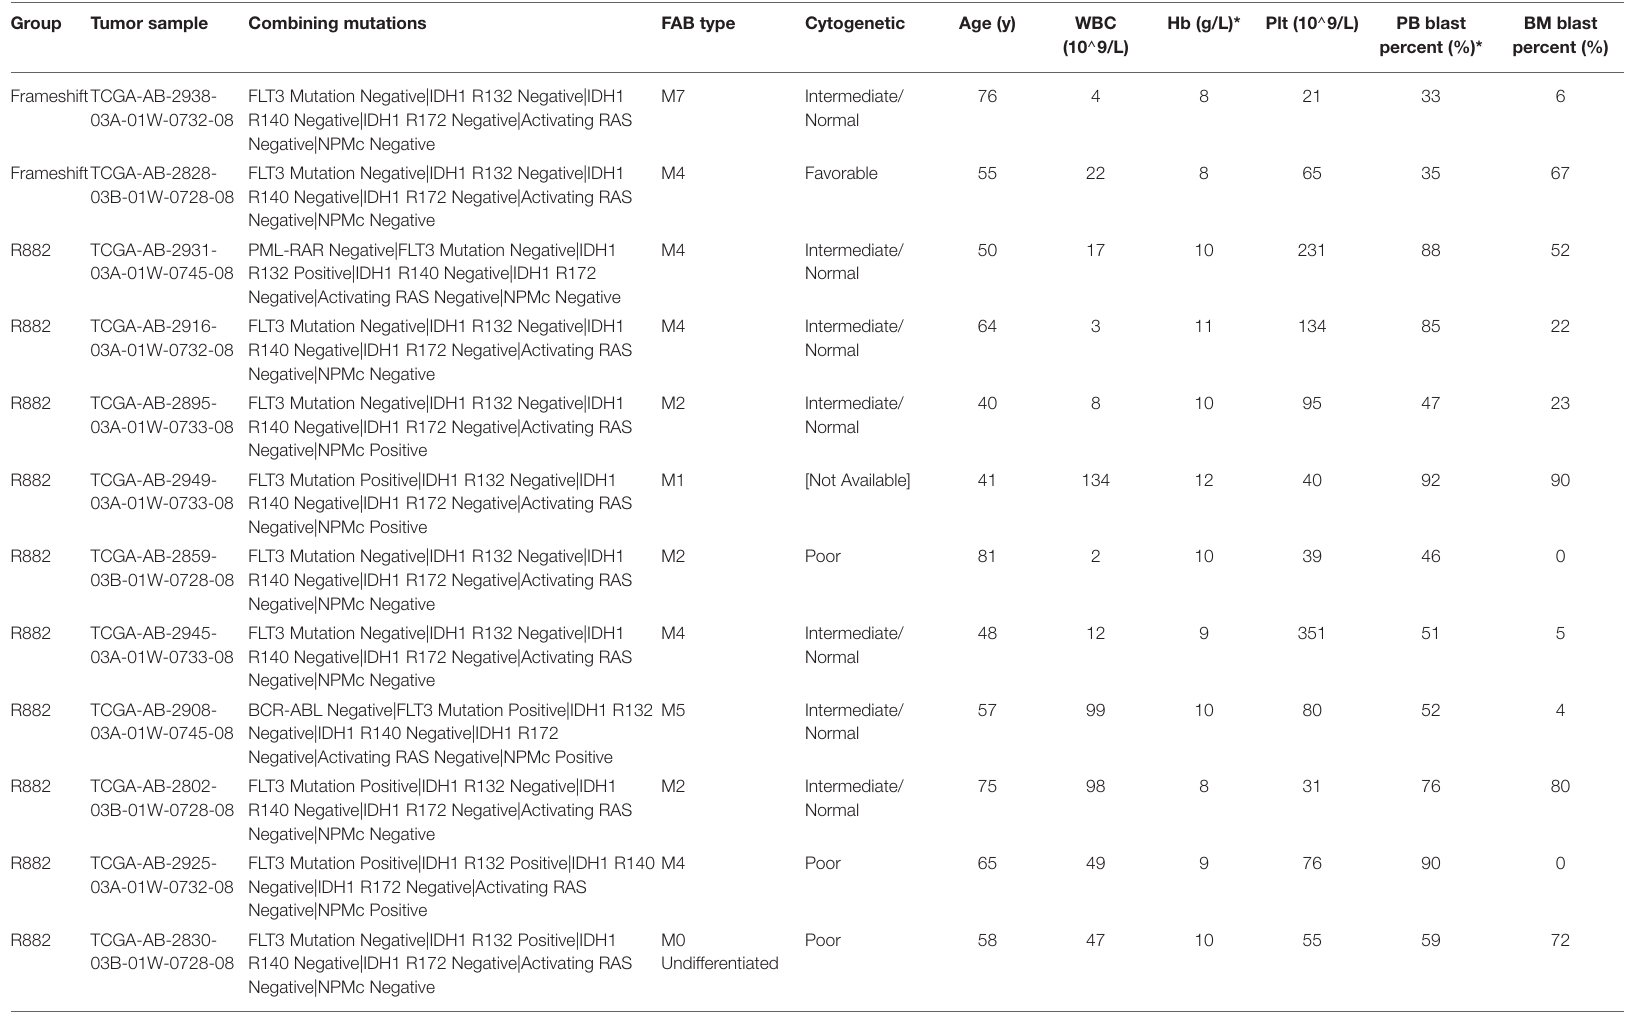
TABLE 2 | Detailed molecular and clinical characteristics of AML patients carrying DNMT3A R882 and DNMT3A frameshift mutations from a cohort in the TCGA database. Group Tumor